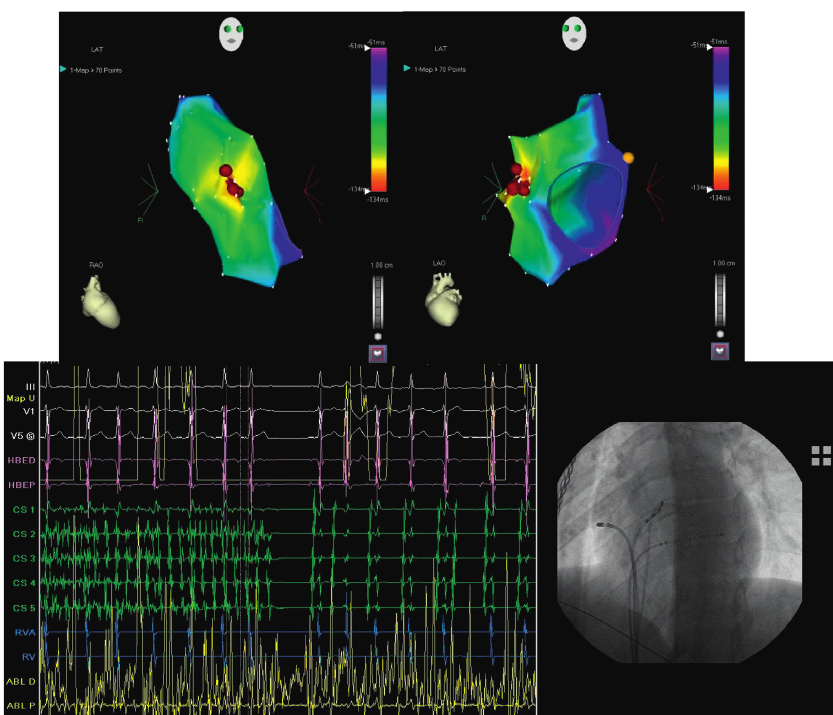
Figure 3: In the upper panels, Carto V2 (Biosense Webster, Johnson and Johnson) activation maps show the maximum earliness (red zone) of the origin of tachycardia in the right atrium (crista terminalis). In the lower panel, traces during radiofrequency delivery (during AF) with the restoration of sinus rhythm and the appearance of irritative beats identical to tachycardia. In the lower right panel, fluoroscopy during radiofrequency